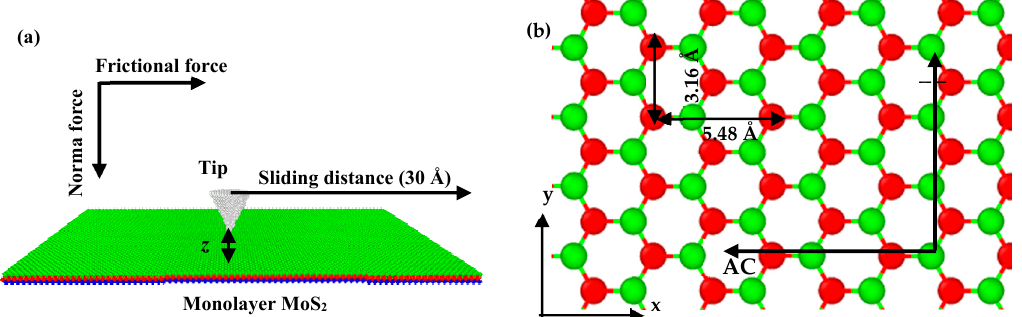
Figure 1. Schematic diagrams of the sliding on a SLMoS 2 ( a ), lattice constants of SLMoS 2 and sliding paths in various lattice orientations of SLMoS 2 ( b ). Blue, red, and green spheres indicate S atoms (bottom layer), Mo atoms (middle layer), and S atoms (top layer) of SLMoS 2 , respectively, and z is the distance between the lowermost atoms of tip and the uppermost layer of S atoms.